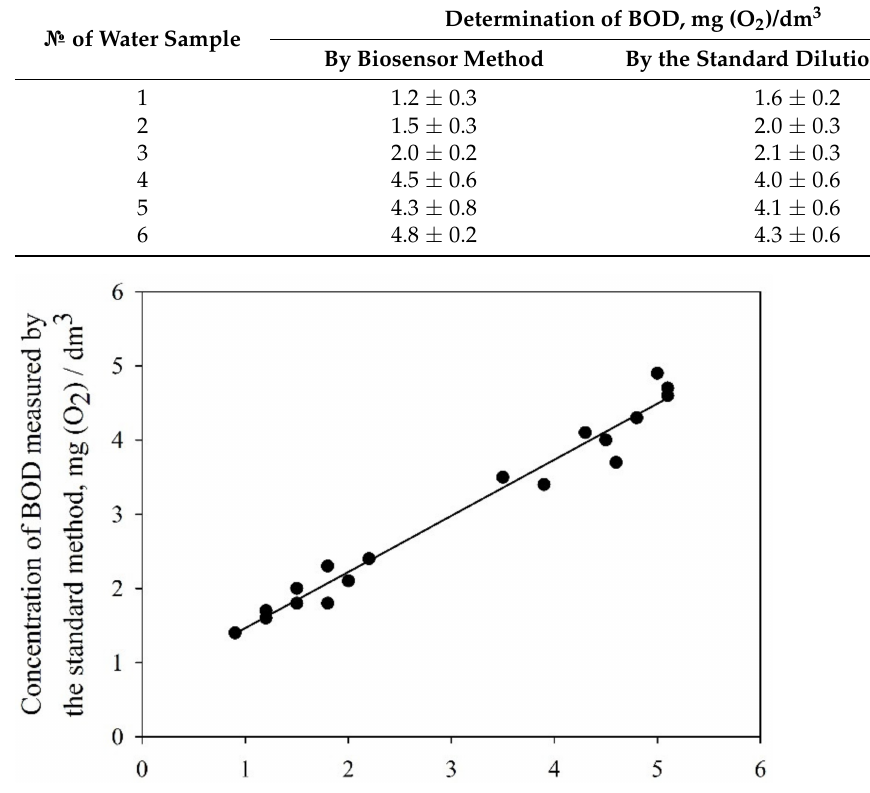
Figure 11. Substrate specificity of the developed biosensor. Table 3. Determination of BOD in real samples.